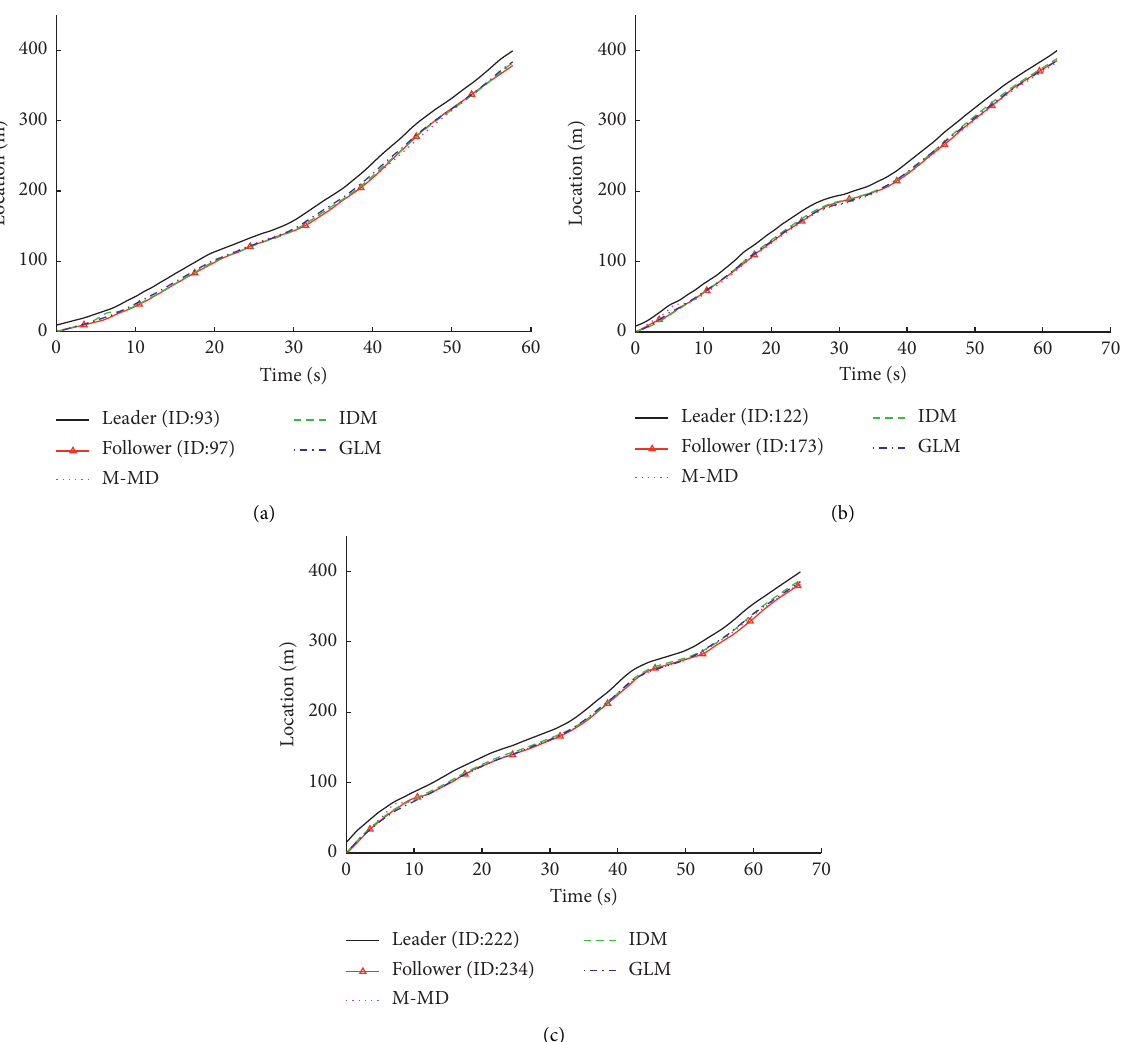
Figure 7: Time-trajectory curves of model simulation. (a) Vehicle 97 follow vehicle 93. (b) Vehicle 173 follow vehicle 122. (c) Vehicle 234 follow vehicle